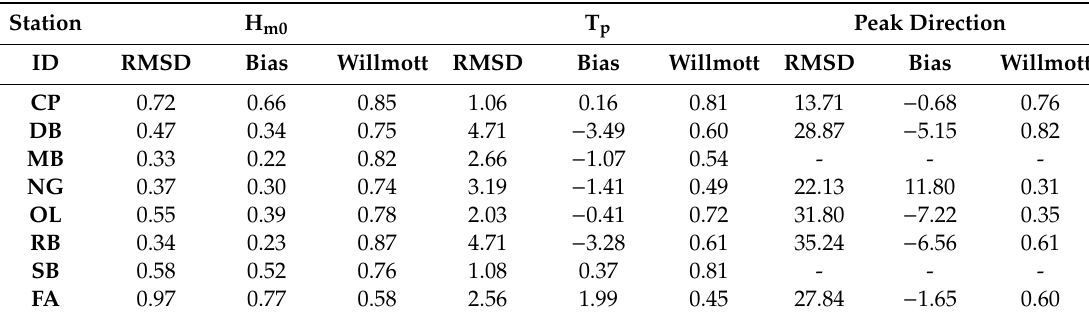
Table A2. Model performance statistics per coastal buoy location for JJA 2017, M2.